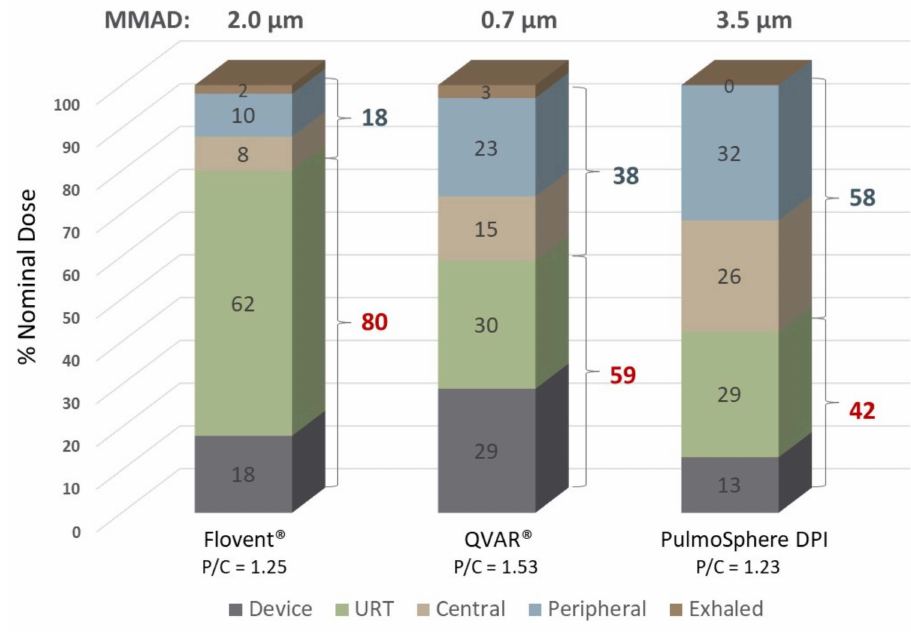
Figure 8. Comparison of regional deposition in the respiratory tract as determined by gamma scintigraphy for various ICS formulations